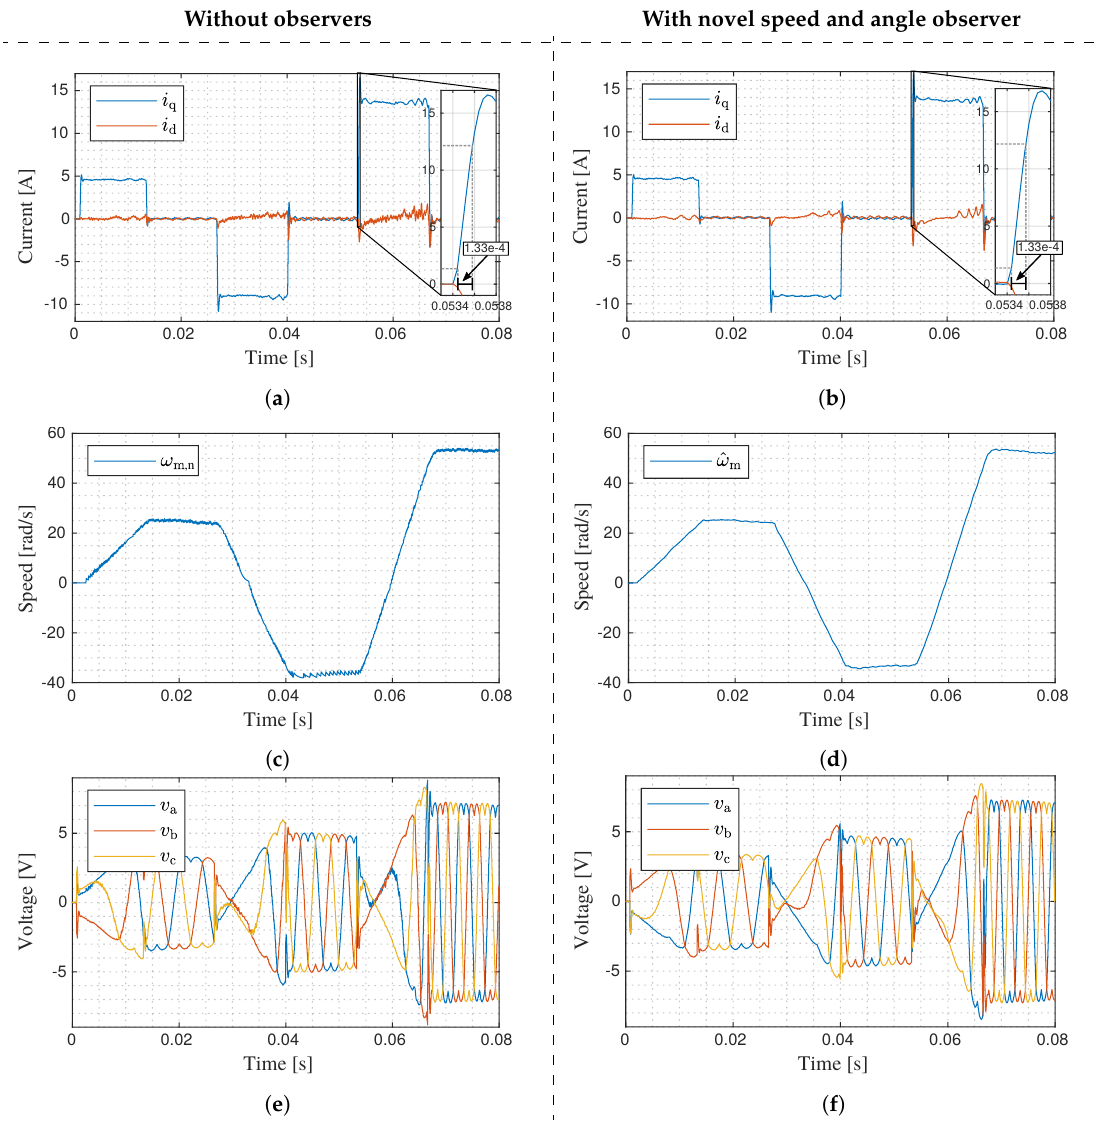
Figure 11. Measured and estimated results from two conducted experiments using torque mode with multiple step in torque reference with zero load—without observer ( a , c , e ) and with the novel angle and speed observer ( b , d , f ). The torque rise times are depicted on ( a , b ). Both speed estimations ω m,n and ˆ ω m are filtered with the same low-pass filter including a 3dB bandwidth of 200Hz for better performance